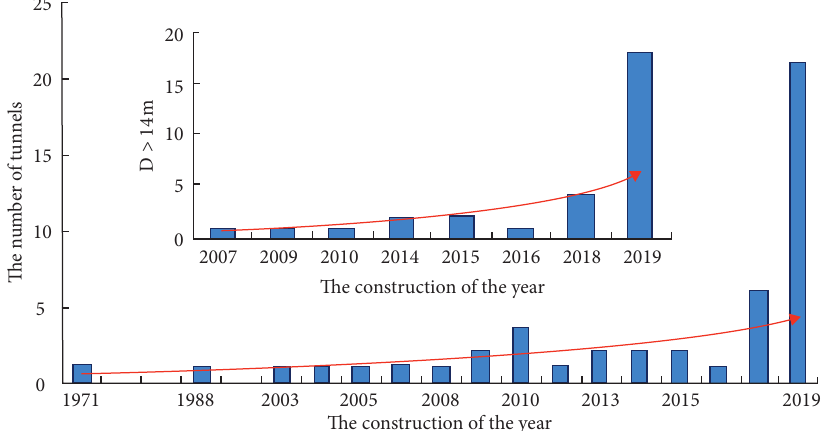
Figure 1: Construction of cross-river shield tunnels in